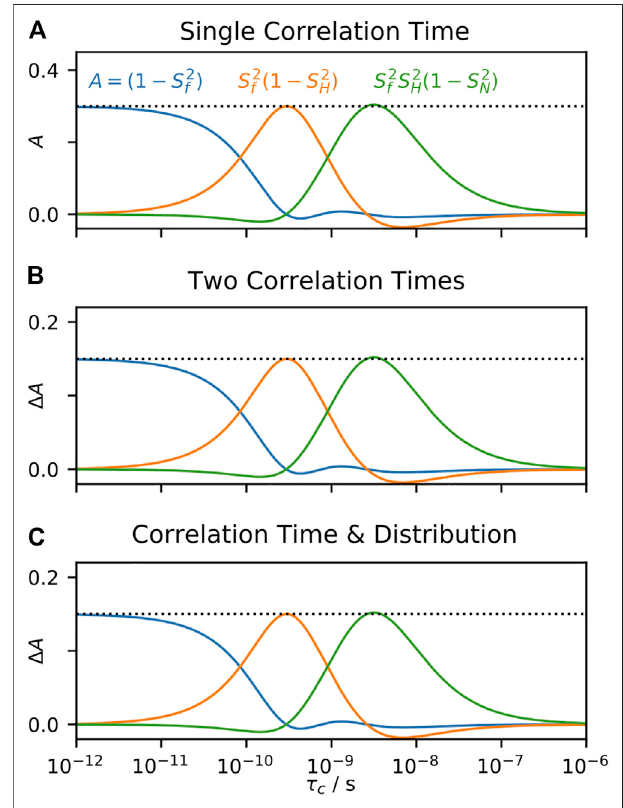
FIGURE7| BehaviorofLeMaster ’ sapproachasafunctionofcorrelation time. In each subplot, we calculate 15 N T 1 , T 2 , and σ NH at 600 MHz for motion with (cid:10) 1 − S 2 (cid:11) (cid:2) 0.3andtumblingcorrelationtimeof τ M (cid:2) 4 ns,andanalyzethe results using Eq. 24 . In (A) the internal correlation function consists of a single decaying exponential term (with amplitude 0.3), where the fi tted amplitudes are plotted as the correlation time is varied. In (B) the internal correlationfunctionusestwocorrelationtimes(bothamplitudesare0.15),with one correlation time fi xed at 10 ps, and the second swept ( x -axis). On the y -axis, we plot contributions to the terms from the correlation time being varied. The resulting behavior is identical to that in (A) , except that the amplitudeishalf,sincewehavesplitthetotalamplitudebetweenthe fi xedand variablecorrelation time (dashedlinemarks0.15).In (C) ,thesameinformation is plotted, but the total correlation function includes a log-Gaussian distribution ( μ (cid:2) 630 ps, σ (cid:2) 1 order of magnitude), and a single, variable correlation